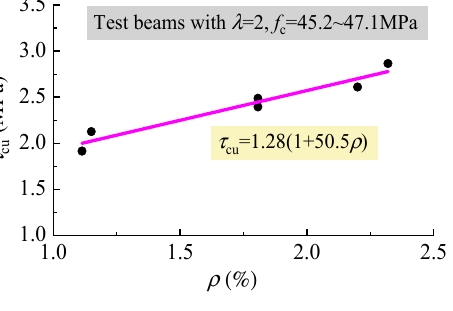
Figure 12. Variations of τ cu with ρ . Figure 11. Variations of τ cu with f fc and f ft.